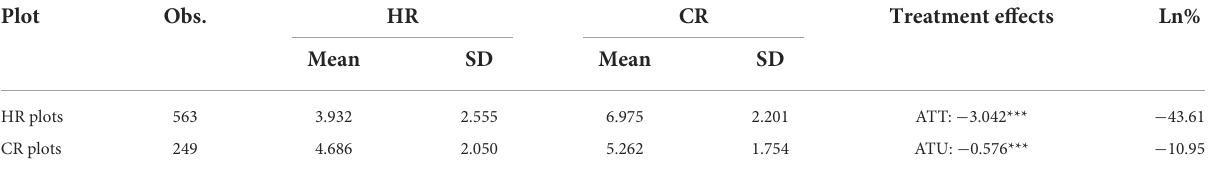
TABLE 5 Average treatment effects of HR on net rice income,